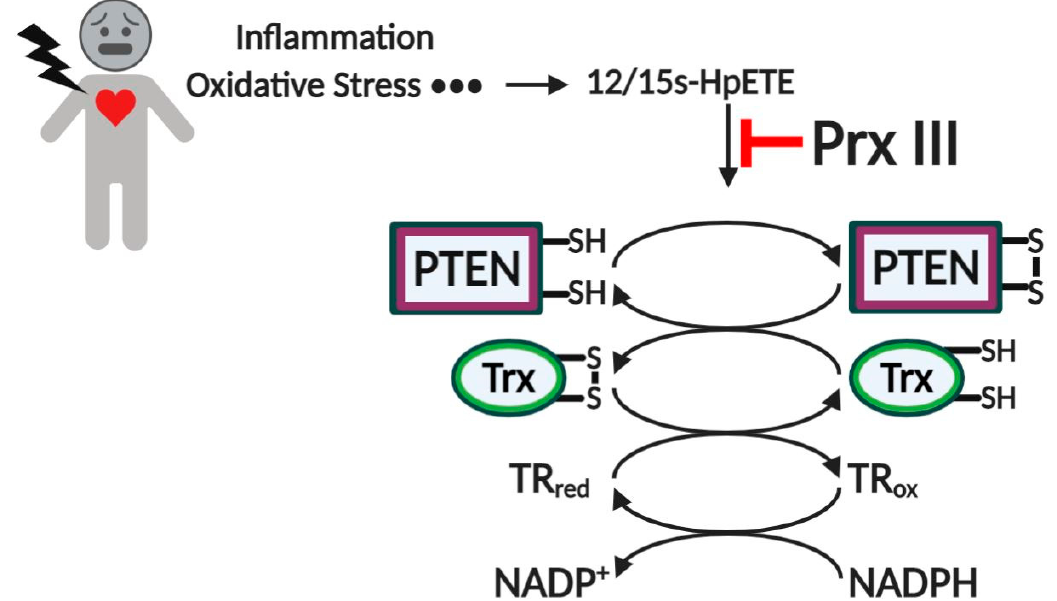
Figure 4. A schematic model for the effect of 12/15s-HpETE and Prx III on the redox regulation of PTEN. Prx III plays an important role in the control of endogenous lipid peroxide-induced redox regulation of PTEN. 12/15s-HpETE inhibits the Trx redox system by inducing dimerization of Trx, resulting in the delayed reduction of oxidized PTEN and oxidized Prx. Prx III prevents 12/15s-HpETE-mediated PTEN oxidation by catalyzing the reduction of lipid peroxide. Black arrows (activating), red arrows (blocking).